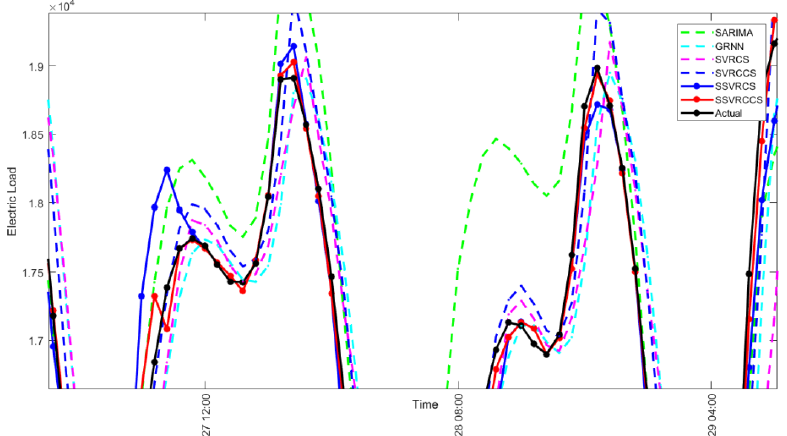
Figure 12. The enlargement comparison of Peaks 3 and 4 from the compared models for Example 2.